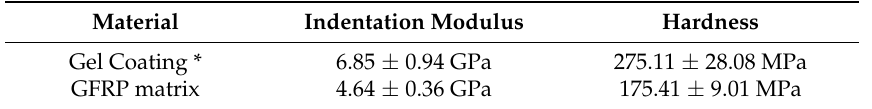
( b ) Figure 21. Layout of the indentation for measuring bulk properties of the gel coating and interphase properties of the two cases of curing. ( a ) Coat 1 (Cured) and ( b ) Coat 2 (Semi-cured). In subsequent testing, lines of indents are carried out across these interfaces through the thickness; see Figure 21. The indents are applied to a maximum depth of 100 nm with a spacing between each indent of 1 µm. For sample Coat 1 (Cured), a distinct interface is detected where the indentation modulus for the EPOLIT GC gel coating is slightly larger than that of the GFRP composite epoxy-based matrix material; see Figure 22. However, for the Coat 2 (Semi-cured) sample, a clear interphase is present between the materials, where the interphase has a much larger stiffness